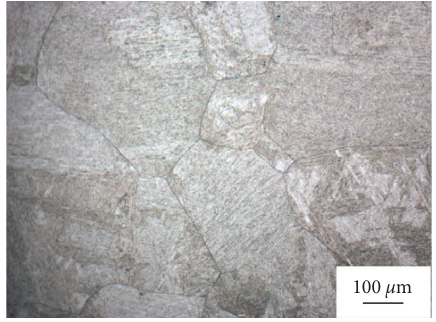
Figure 1: The initial microstructure of 30Cr2Ni4MoV steel.